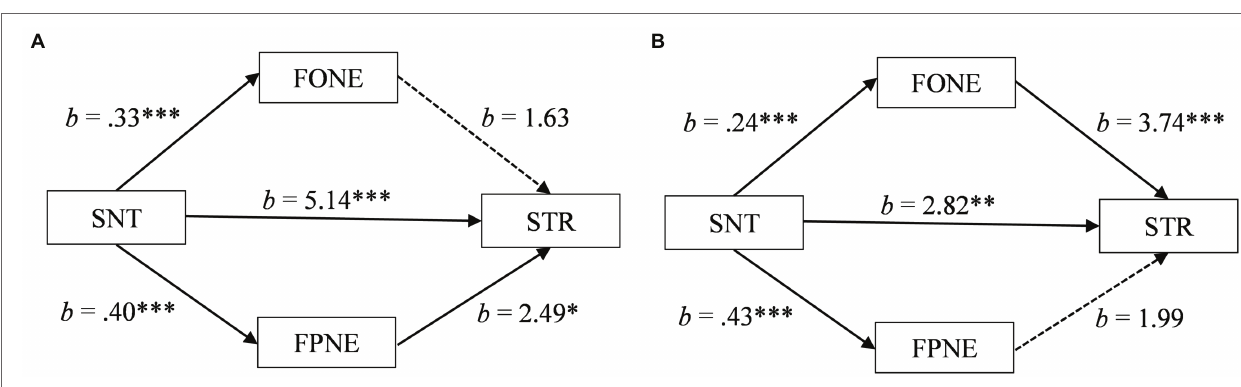
FIGURE 3 | (A) Mediation of social norm transgression (SNT) on stress (STR) through fear of own negative evaluation (FONE) and fear of parental negative evaluation (FPNE) for South Asian participants. (B) Mediation of social norm transgression (SNT) on stress (STR) through fear of own negative evaluation (FONE) and fear of parental negative evaluation (FPNE) for White participants. * p < 0.05, ** p < 0.01, and *** p <